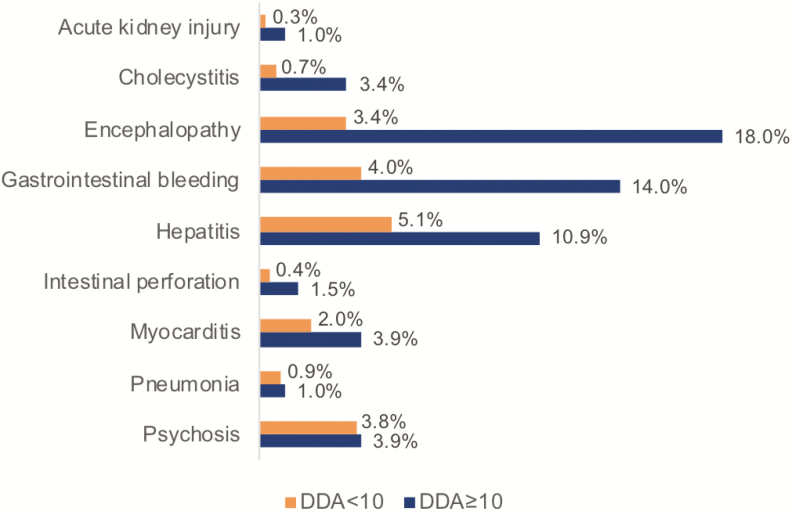
Frequency (pooled across the studies reporting the complications and illness duration at hospitalization) of typhoid fever complications (1990–2018). Abbreviation: DDA, mean/median illness duration at hospitalization.